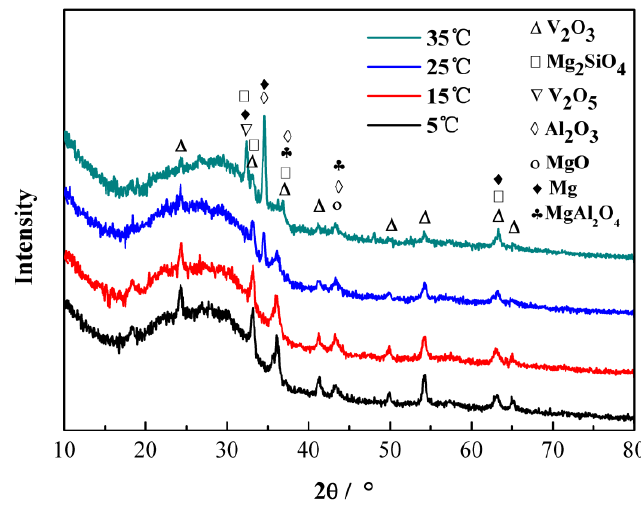
Figure 2. XRD spectra of PEO coatings fabricated at different electrolyte temperatures.